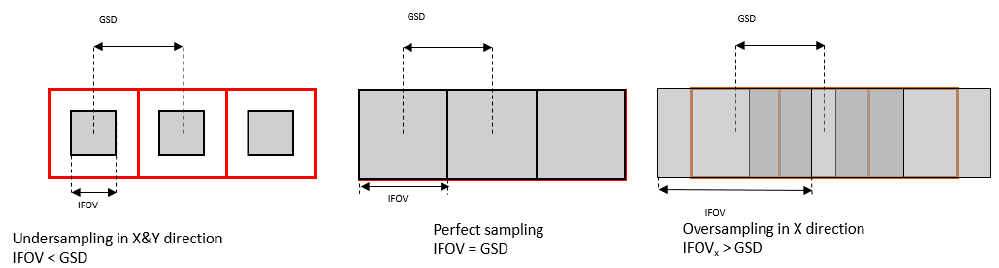
Figure 8. Different sampling conditions. Three ground pixels are equally spaced, however, depending on instantaneous field of view (IFOV) detectors, this scene might be over / under sampled.